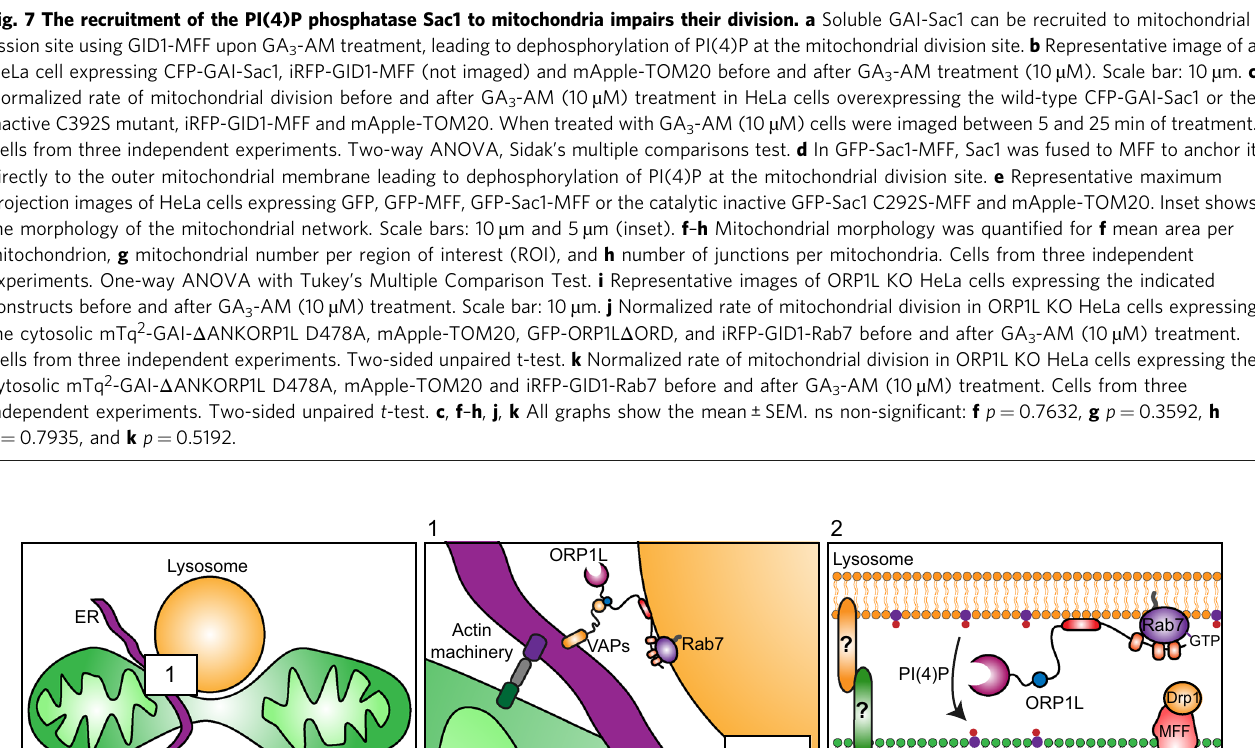
Fig. 7 The recruitment of the PI(4)P phosphatase Sac1 to mitochondria impairs their division. a Soluble GAI-Sac1 can be recruited to mitochondrial fi ssion site using GID1-MFF upon GA 3 -AM treatment, leading to dephosphorylation of PI(4)P at the mitochondrial division site. b Representative image of a HeLa cell expressing CFP-GAI-Sac1, iRFP-GID1-MFF (not imaged) and mApple-TOM20 before and after GA 3 -AM treatment (10 µ M). Scale bar: 10 µ m. c Normalized rate of mitochondrial division before and after GA 3 -AM (10 µ M) treatment in HeLa cells overexpressing the wild-type CFP-GAI-Sac1 or the inactive C392S mutant, iRFP-GID1-MFF and mApple-TOM20. When treated with GA 3 -AM (10 µ M) cells were imaged between 5 and 25 min of treatment. Cells from three independent experiments. Two-way ANOVA, Sidak ’ s multiple comparisons test. d In GFP-Sac1-MFF, Sac1 was fused to MFF to anchor it directly to the outer mitochondrial membrane leading to dephosphorylation of PI(4)P at the mitochondrial division site. e Representative maximum projection images of HeLa cells expressing GFP, GFP-MFF, GFP-Sac1-MFF or the catalytic inactive GFP-Sac1 C292S-MFF and mApple-TOM20. Inset shows the morphology of the mitochondrial network. Scale bars: 10 µ m and 5 µ m (inset). f – h Mitochondrial morphology was quanti fi ed for f mean area per